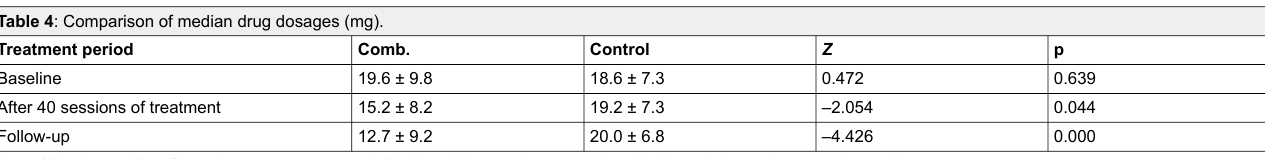
Table 4 : Comparison of median drug dosages